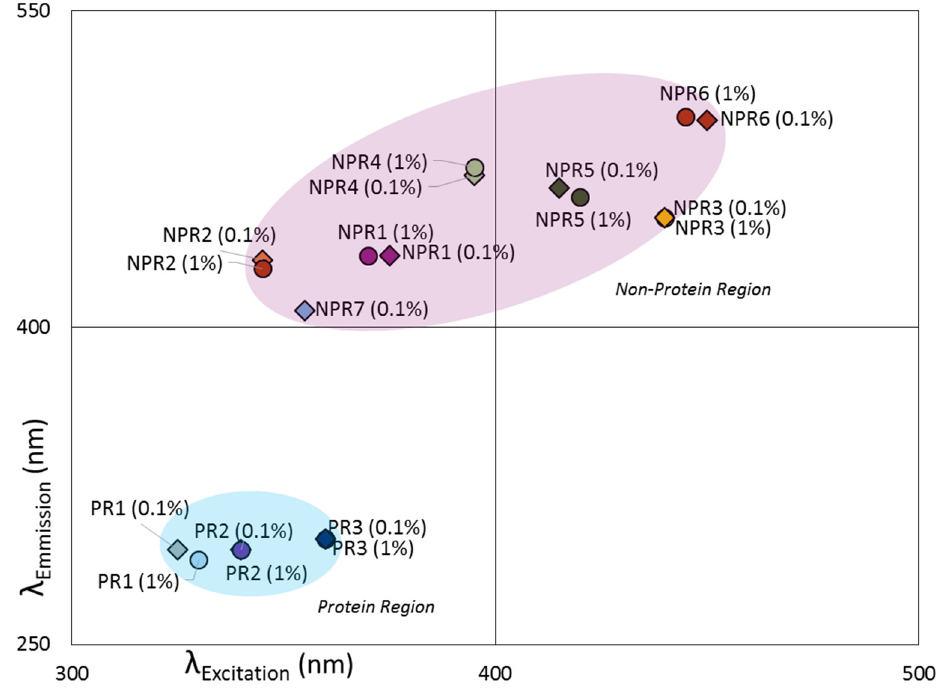
Figure 1. Fluorescence/PARAFAC Components: Illustration of the separation of the PARAFAC components based on their maximum excitation and emission wavelengths.